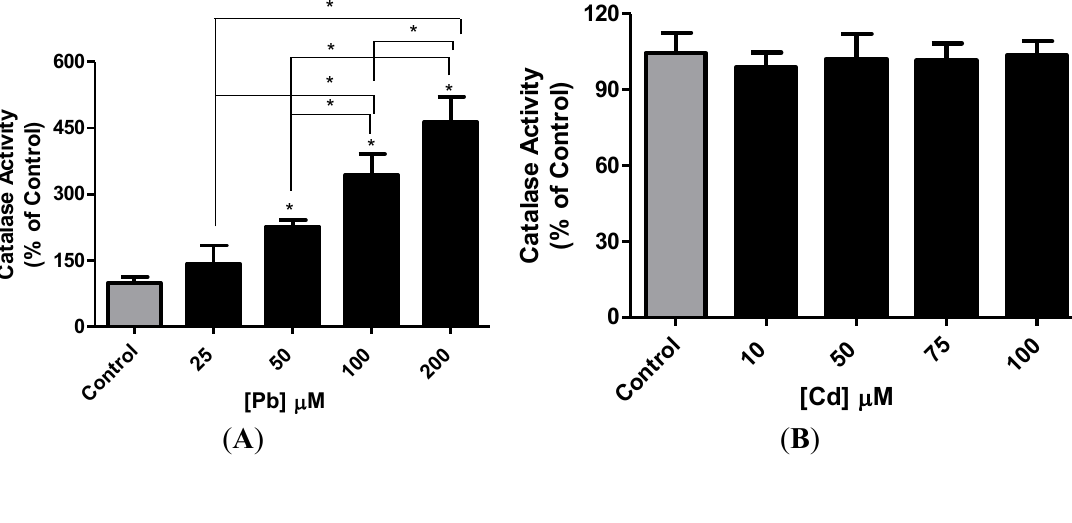
Figure 4. Catalase activity in hCMEC/D3 cells after treatment with ( A ) Pb and ( B ) Cd. Cells were exposed to different concentrations of Pb (25–200 µM) and Cd (10–100